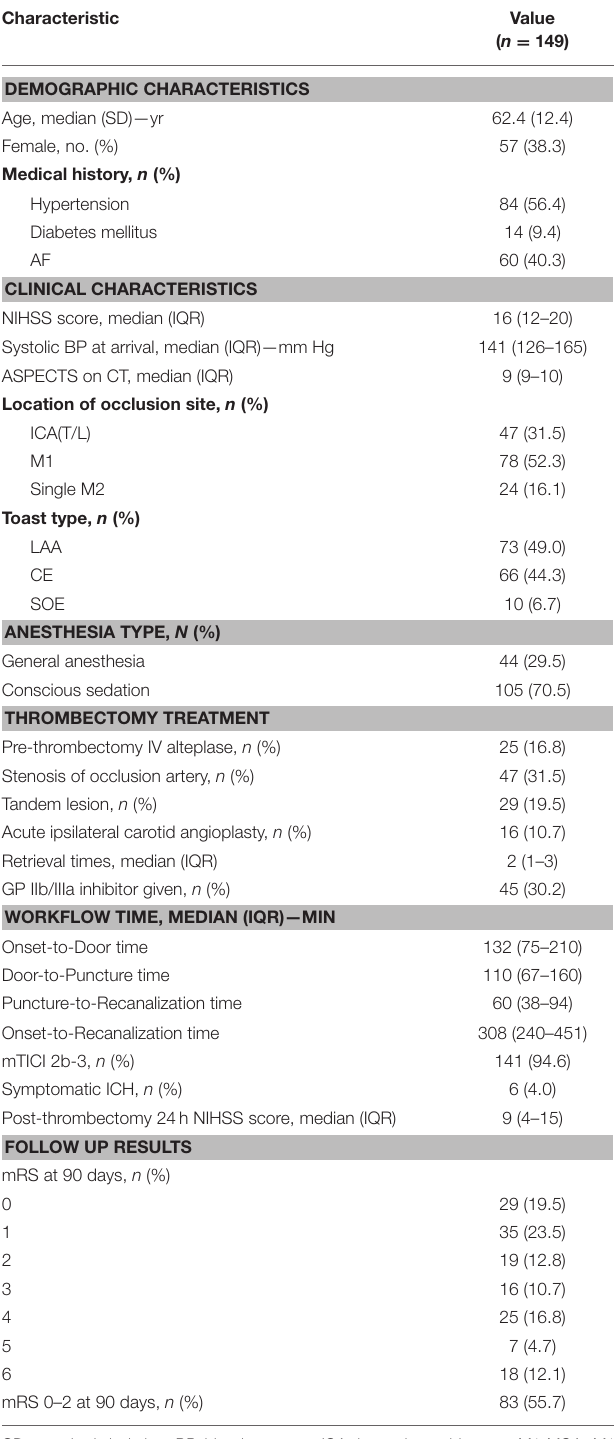
TABLE 1 | Baseline and treatment characteristics of AIS patients receiving